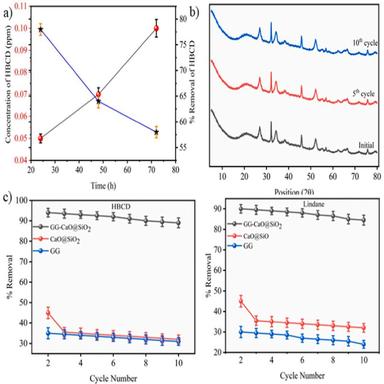
(a) Leaching of HBCD from EPS packing (0.1 g in 500 mL) for different time interval and degradation of HBCD leachate (b) PXRD data of nanocomposite initial, 5th and 10th cycle (c) Reusability analysis of nanocomposite for the removal of HBCD and Lindane up to 10th cycle.